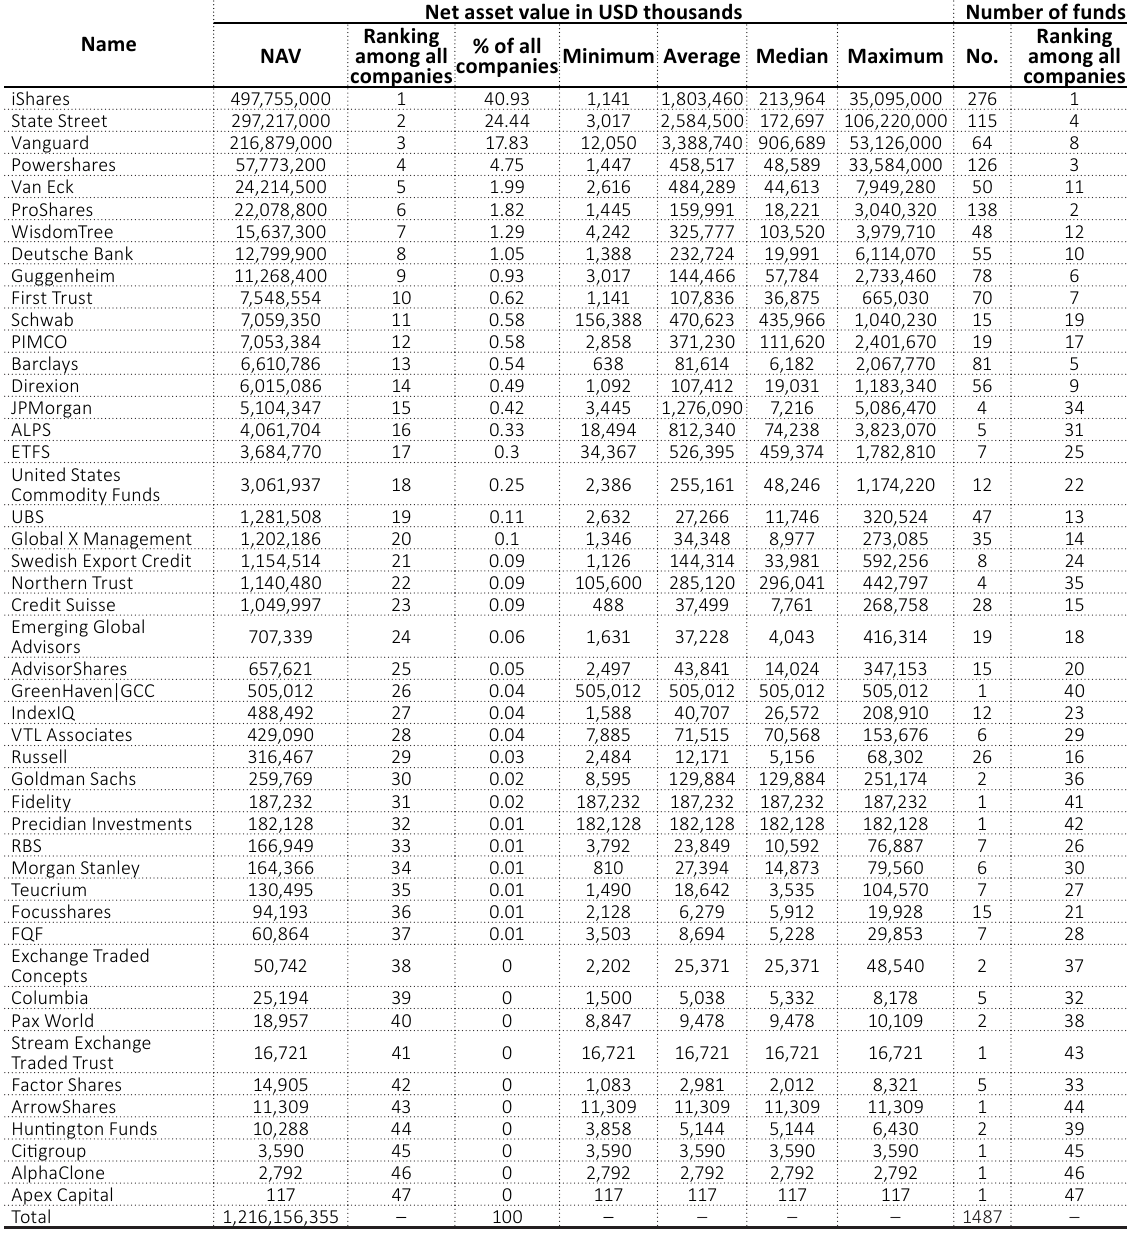
Table 2. Statistics of ETF providers by net asset value and the number of ETFs as of August 6, 2012